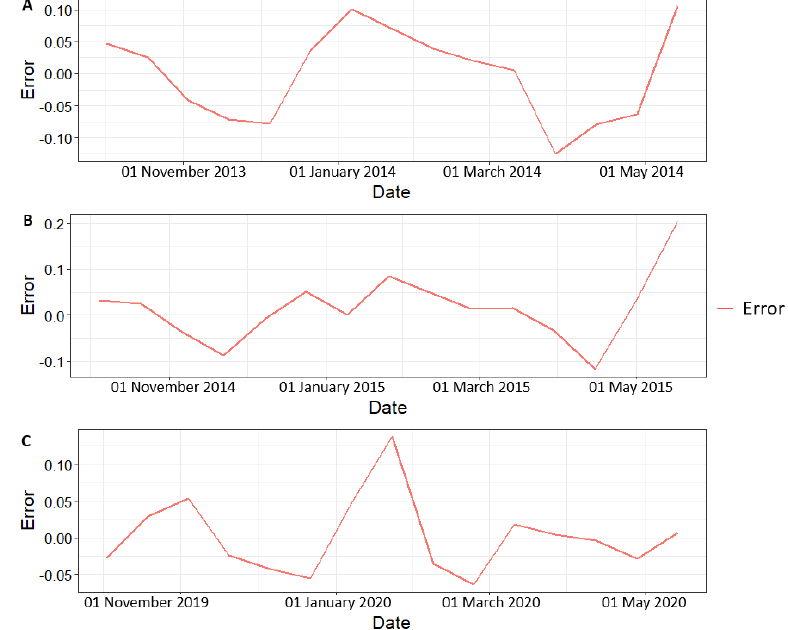
Figure 6. Mean error derived from the H-NDVI for the study area using the three time windows. ( A ) Mean H-NDVI error for the 2013/2014 season. ( B ) Mean H-NDVI error for the 2014/2015 season. ( C ) Mean H-NDVI error for the 2019/2020 season.